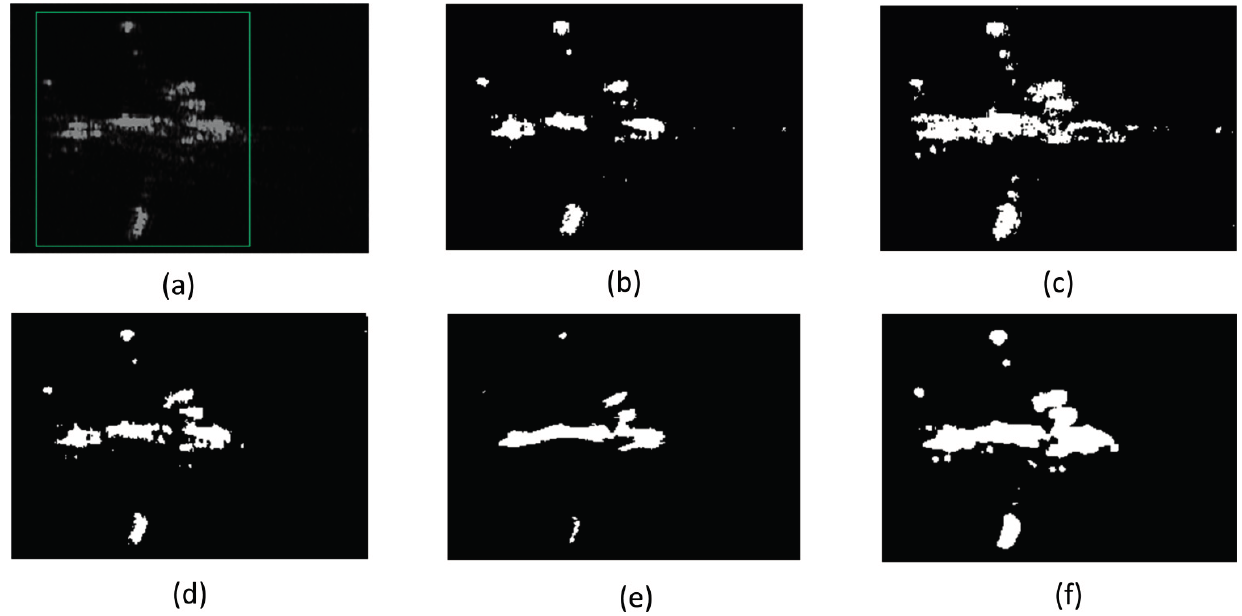
Figure 15. Results of different detector in condition of one-target situation. ( a ) is the original image for example; ( b ) is the result of VI-CFAR detector; ( c ) is the result of SCCA-CFAR detector; ( d ) is the result of TL-CFAR detector; ( e ) is the result of LED detector; ( f ) is the result of GTS detector. The region labeled by a green rectangle in ( a ) is the aircraft target in the real SAR image patch ( a